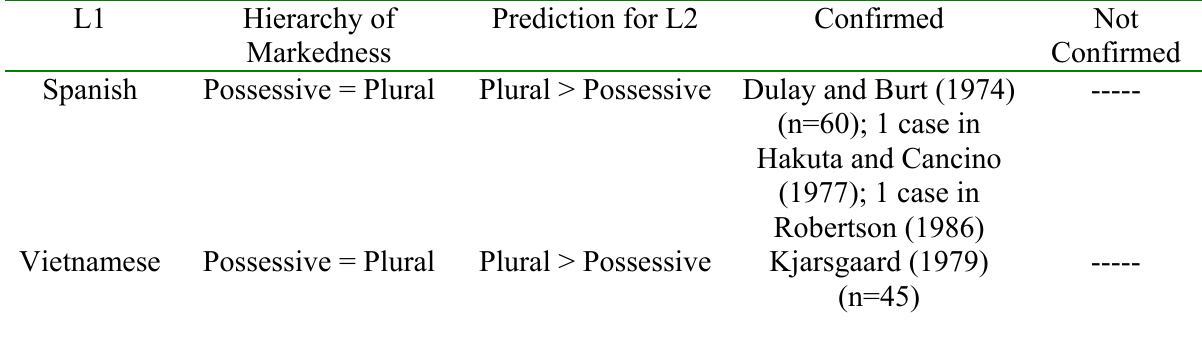
English L2 Plural –s and Possessive –’s in Group B